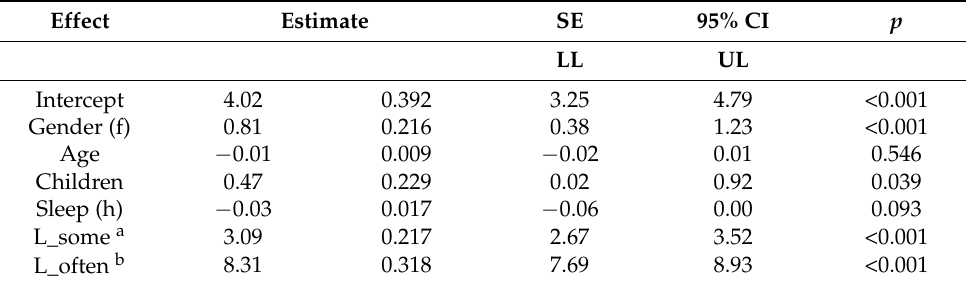
Table 3. Associations with overall Patient Health Questionnaire-9